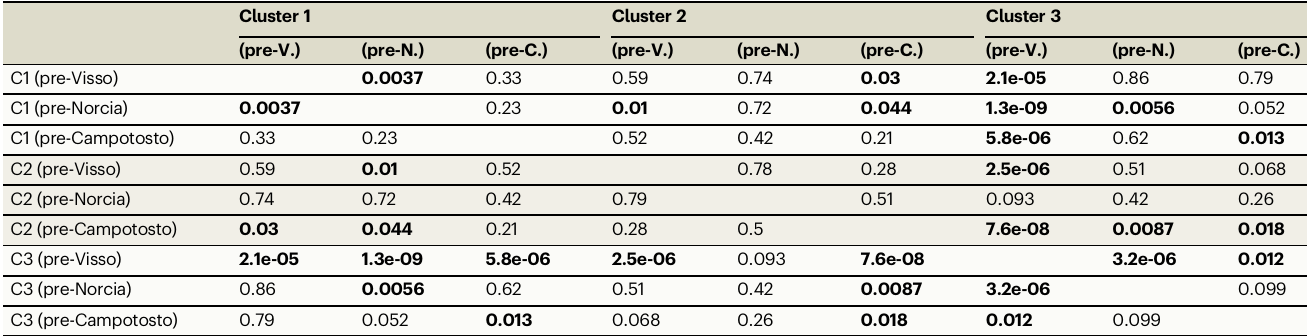
Table 2 | Pairwise MFD comparison of temporal subsets Cluster 1 Cluster